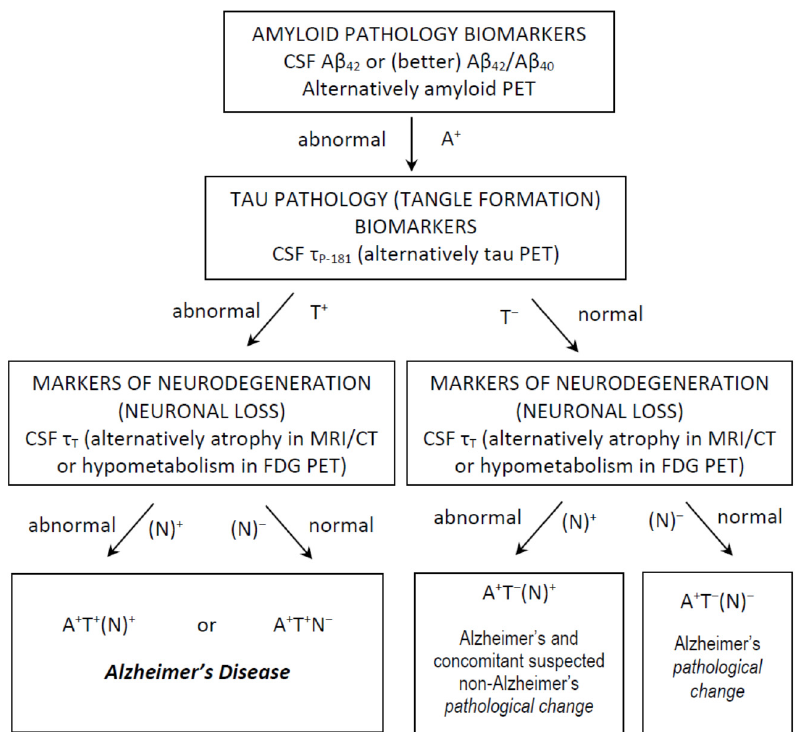
Figure 1. Use of CSF classical biomarkers and the AT(N) classification system in everyday clinical practice, for the diagnosis of Alzheimer’s disease and Alzheimer’s pathological change . Other profiles are not compatible with Alzheimer’s continuum and are not shown.